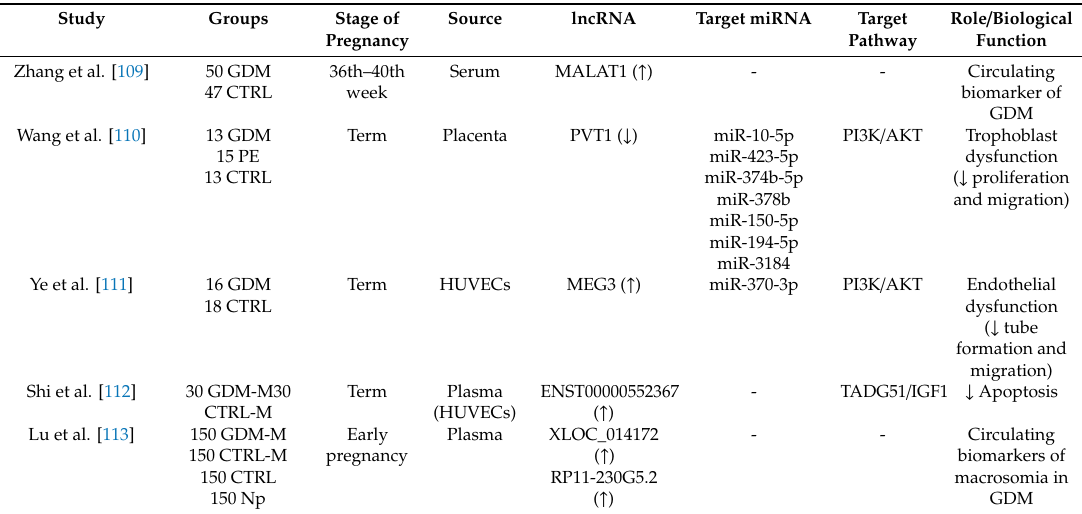
Table 2. Studies that evaluated the role and biological functions of lncRNAs in